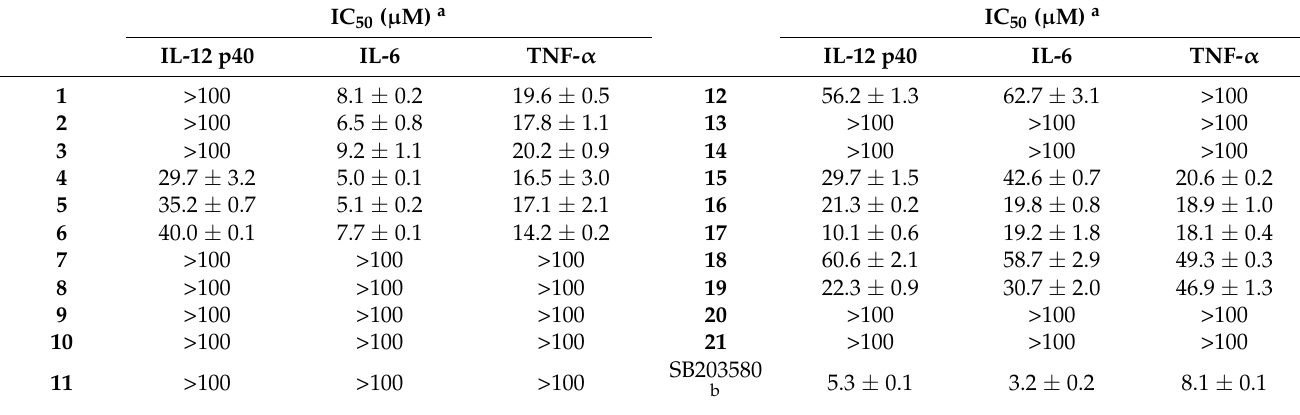
Table 2. Anti-inflammatory effects of compounds 1 – 21 isolated from P. grandiflorum root on LPS-stimulated RAW264.7